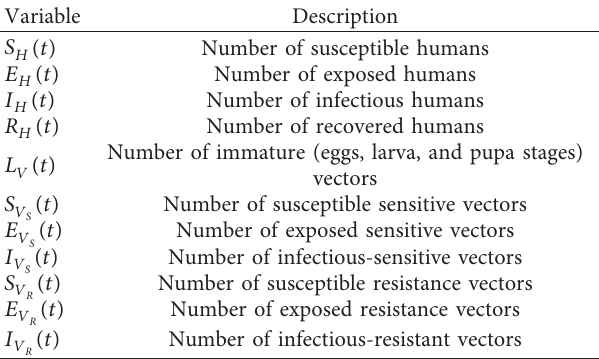
Table 4: Description of the variables of model